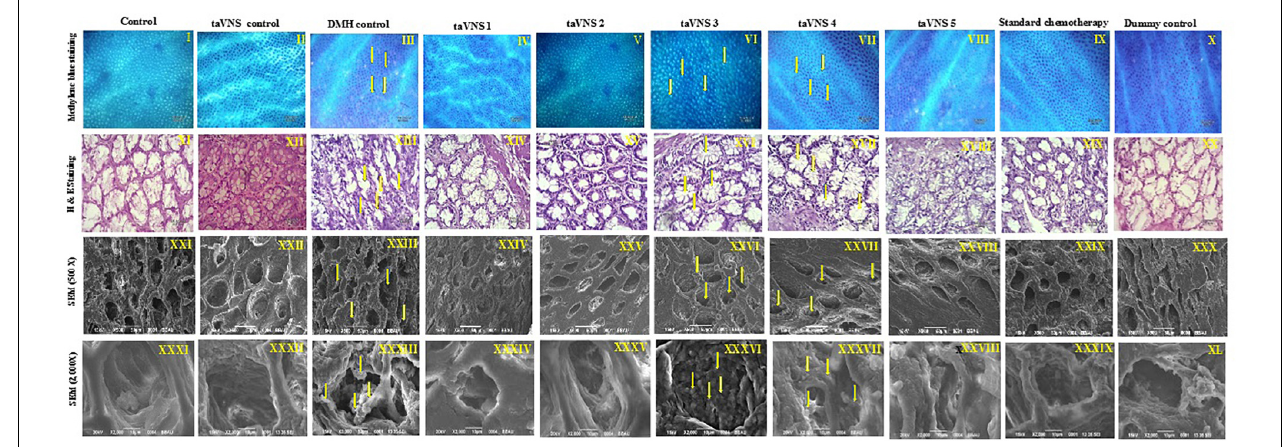
FIGURE 2 | Methylene blue staining, H&E staining, and scanning electron microscopy of colon tissue. I–X – Methylene blue staining of colon tissue; XI–XX – represents H&E staining of colon tissue; XXI–XXX – represents scanning electron microscopy of colon tissue (500X) and XXXI–XL – represents scanning electron microscopy of colon tissue (2000X) depicts presence of small neoplastic lesions on mucosal tissue of DMH control. The arrows represent ACF formation and neoplastic lesions.